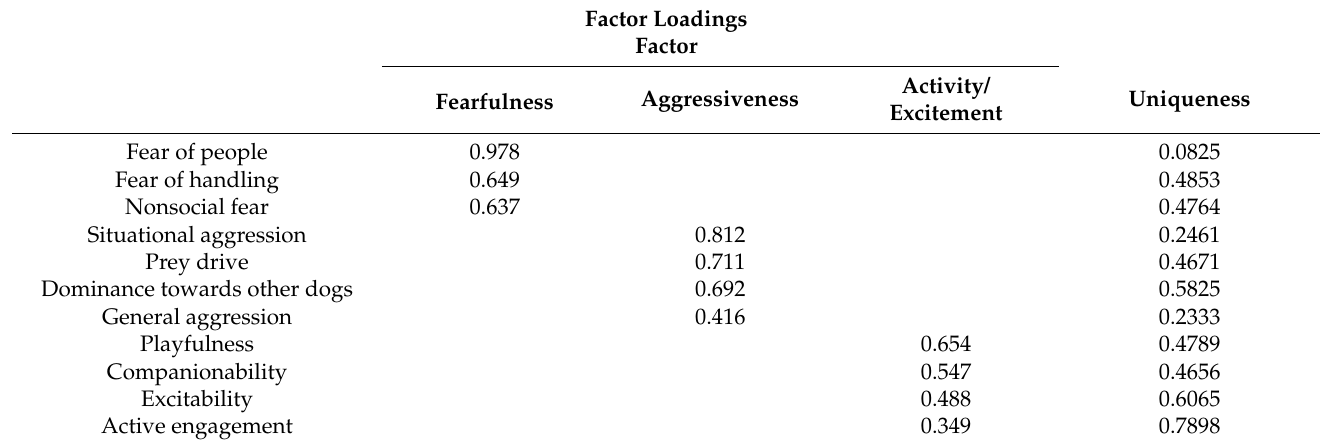
Table 3. Factor loadings. Facet 1—excitability; Facet 2—playfulness; Facet 3—active engagement; Facet 4—companionability. The ‘Minimum residual’ extraction method was used in combination with an ‘oblimin’ rotation.